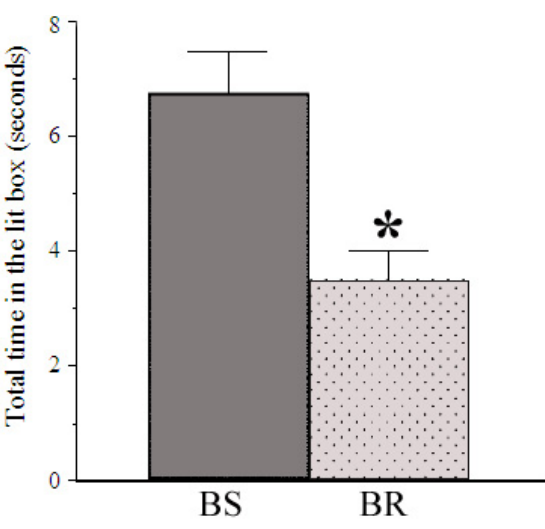
FIGURE 10. Reactions of BS and BR mice in an anxious situation . Behavior was observed for 5 min in an experimental setup comprised of two identical boxes, one dark and one lit. Anxious mice spent more time in the dark. Time spent in the lit box was interpreted, therefore, as an index of “nonanxious” behavior. The total time spent in the lit box was greater for BS mice, which led to the deduction that BR mice were more anxious. (Adapted from Suaudeau et